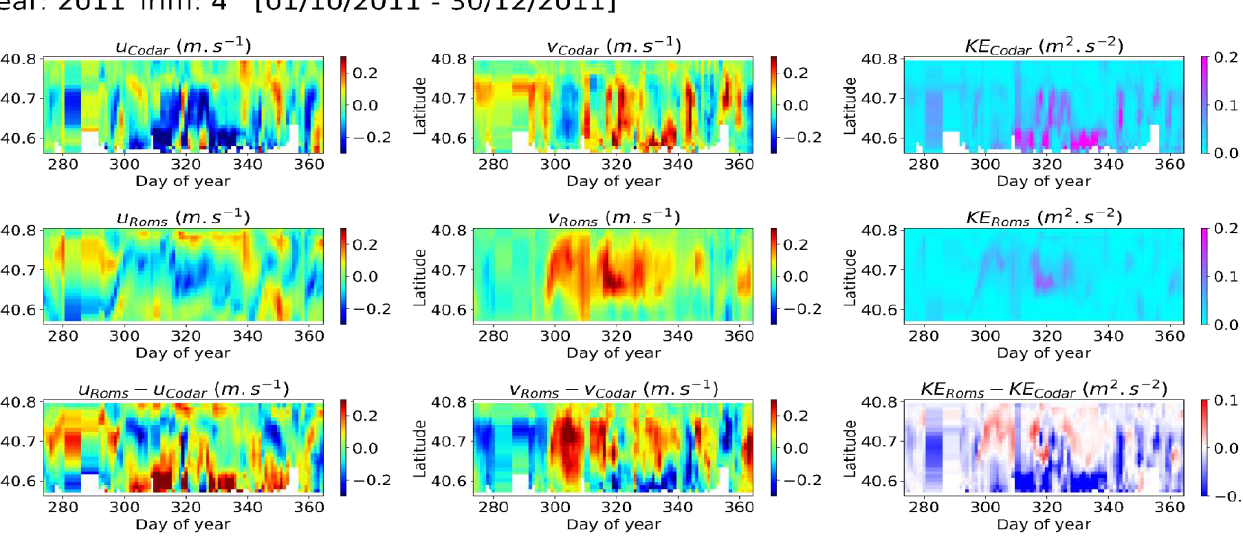
Figure 7. Hovmöller diagrams of the zonal and meridional component of the surface current (cm/s) and kinetic energy measured by the HFR and obtained from model simulation over the transect for the quarter OND in 2011.